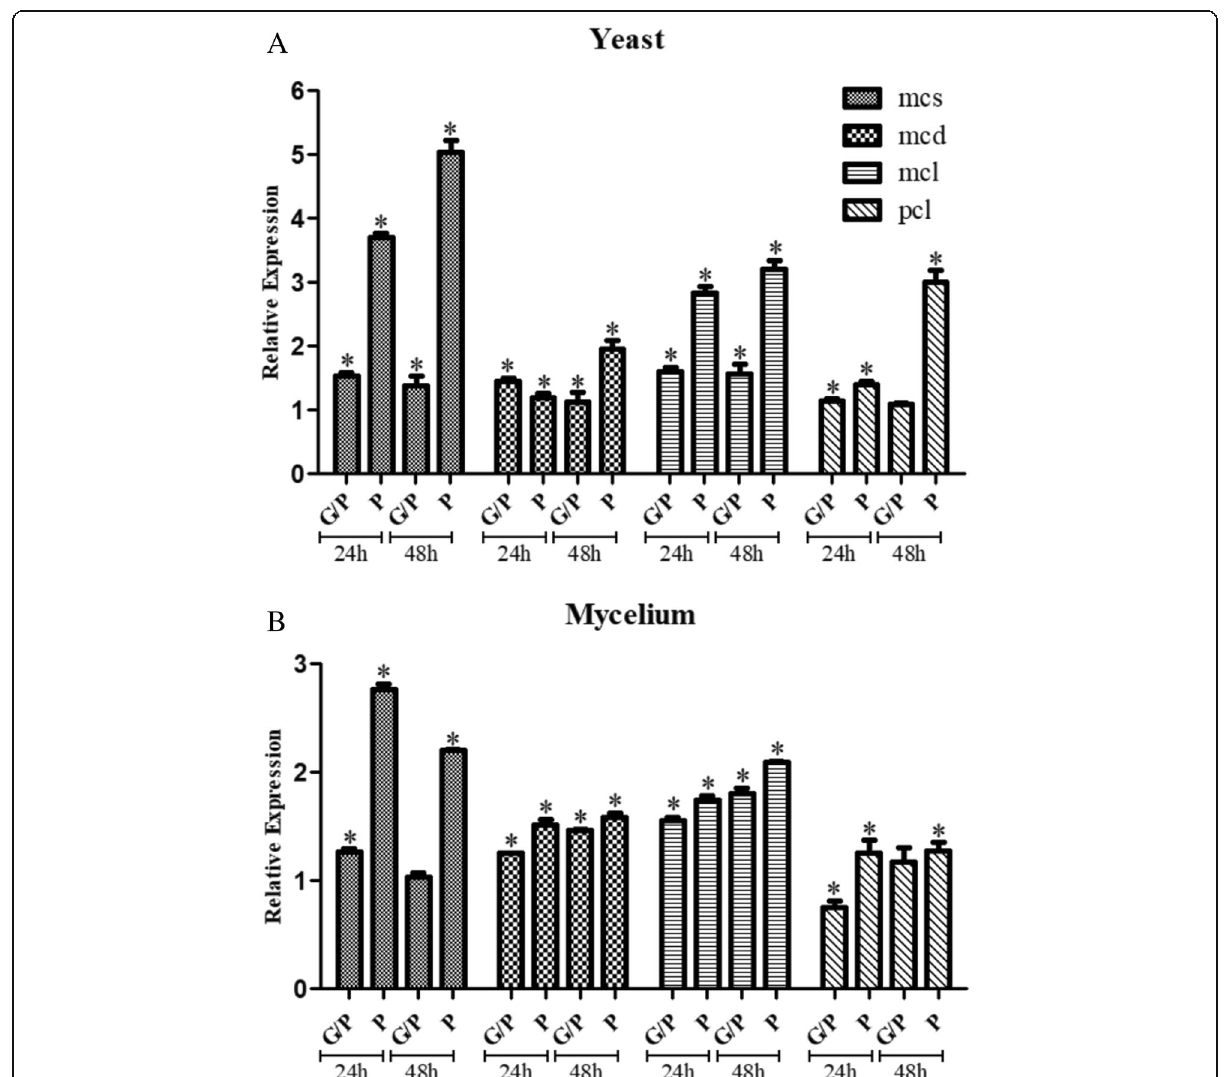
Fig. 4 Expression analysis of the genes related to propionate metabolism on different carbon sources. Expression levels of the mcs , mcd, mcl and pcl genes from mycelium ( b ) and yeast ( a ) cells of P. lutzii grown in propionate (P) and glucose plus propionate (GP). The gene expression levels of propionate and glucose plus propionate were normalized to glucose condition (control carbon source). Error bars represent the standard deviation from the average obtained from triplicates; * p <